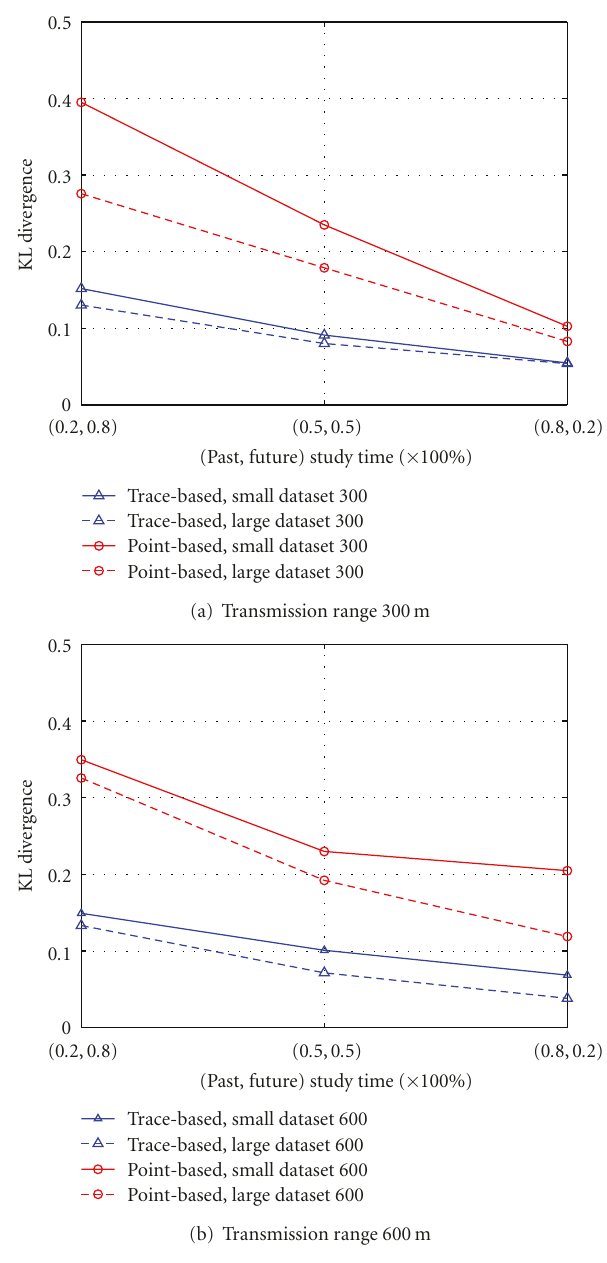
Figure 7: Comparison of KL-divergence between the small and the large data sets in walking